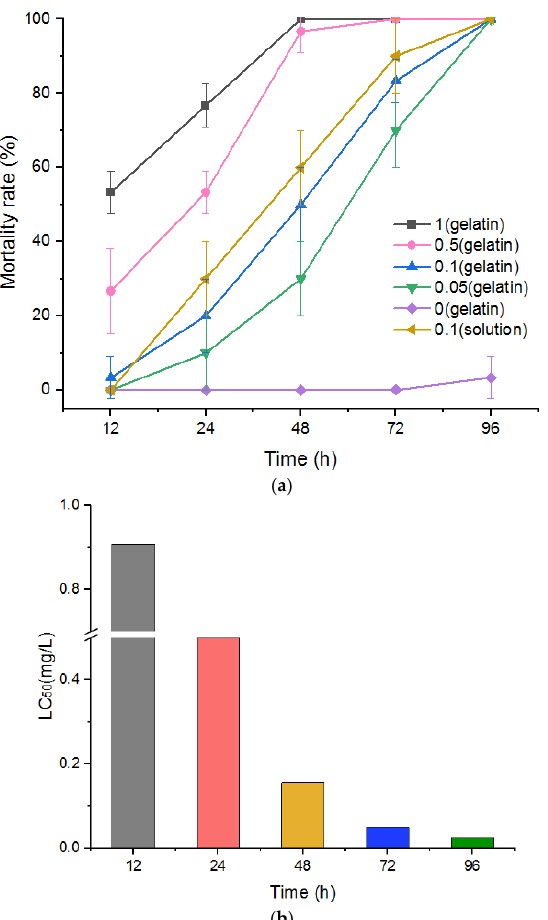
Figure 5. ( a ) Fitting curve of P. canaliculata mortality at different times and under different concen- trations of sustained-release niclosamide gelatin preparation. Significantly different from the cor- responding control, P < 0.05 (n = 3). ( b ) LC 50 (mg/L) of P. canaliculata treated with niclosamide gel- atin sustained-release agent at different concentrations. 3.6. Test of Control Effect of Niclosamide-Containing Gelatin on P. canaliculata Eggs To observe the control effect of niclosamide-containing gelatin on snail eggs, gelatin containing final concentrations of 0, 0.05, 0.1, 0.5, and 1 mg/L niclosamide was prepared, and P. canaliculata eggs were observed after these gelatin treatments were applied to the